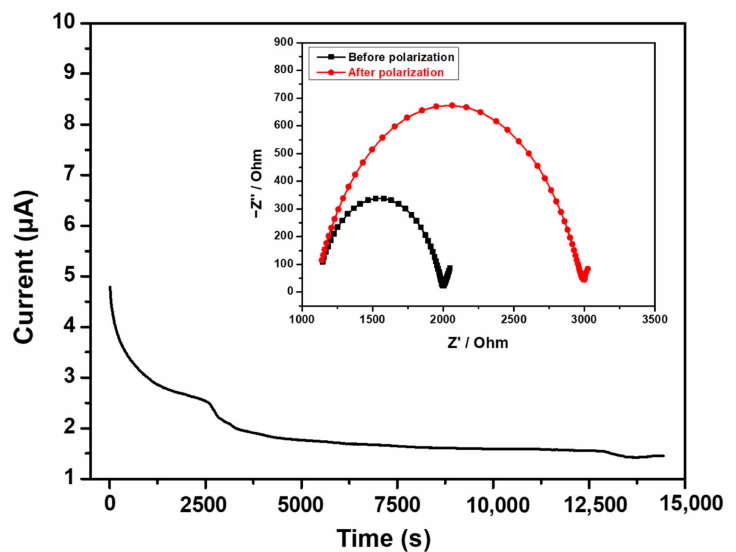
Figure 5. Chronoamperometry of the Li/PEO 114 - b -PDM 15 -dTFSI-1/5/Li cell. The inset presents the electrochemical impedance spectroscopy (EIS) before and after polarization.